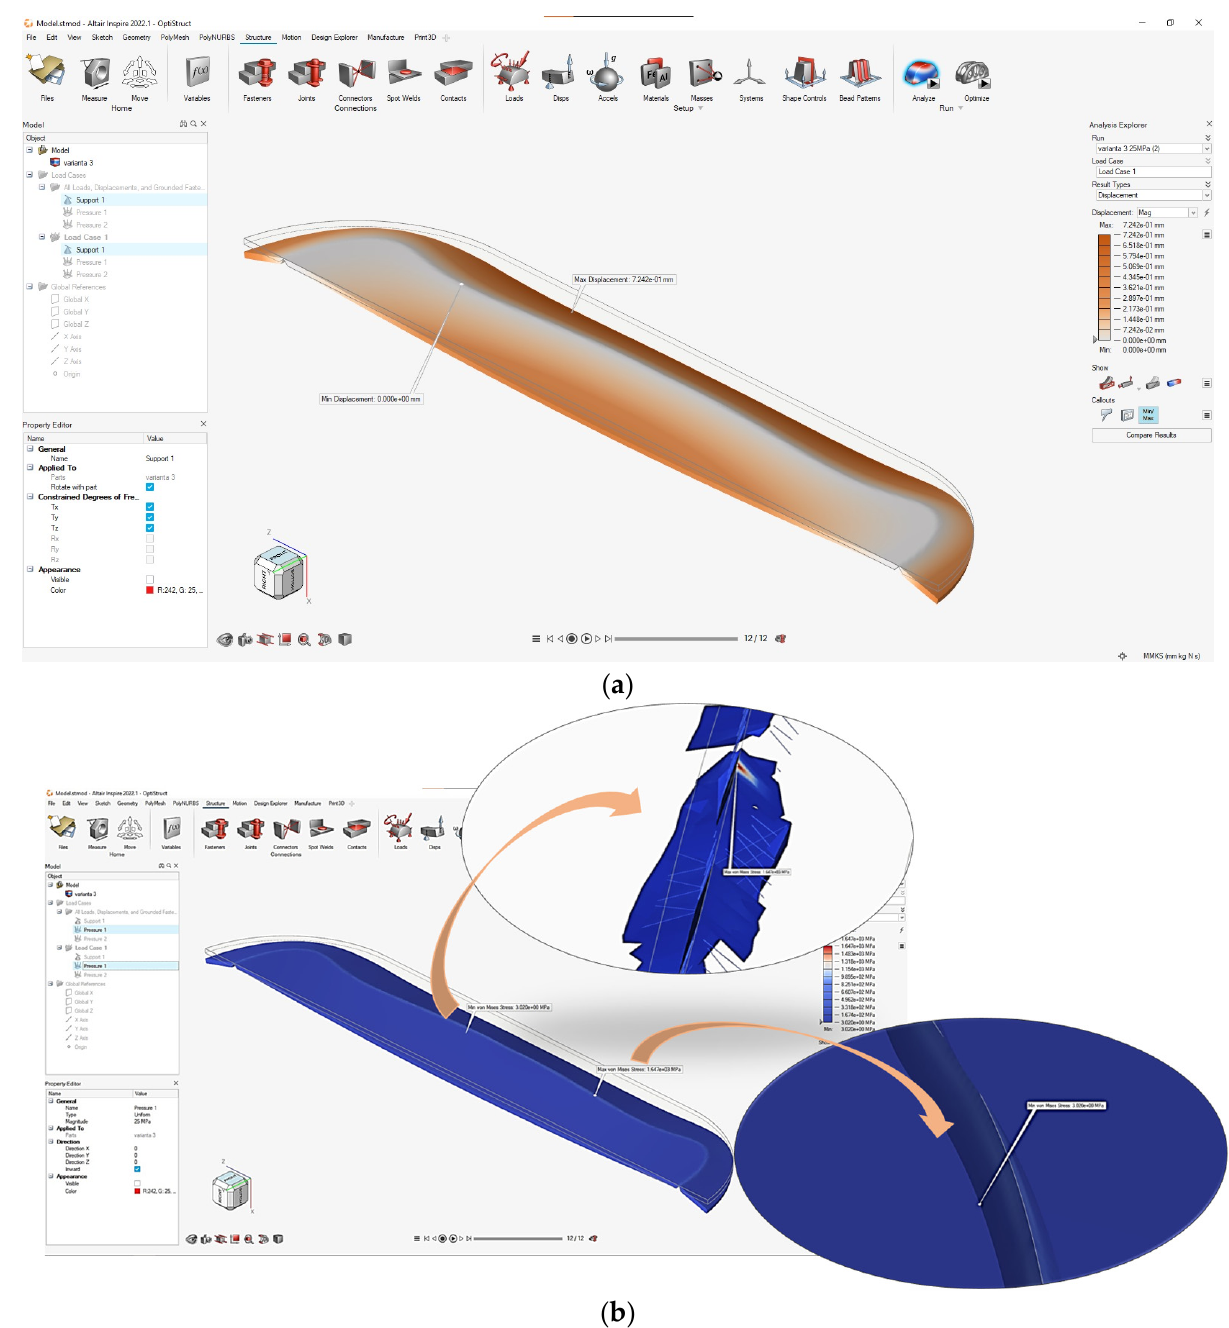
Figure 31. The model no. 2: ( a ) deformations; ( b ) von Mises equivalent stresses.